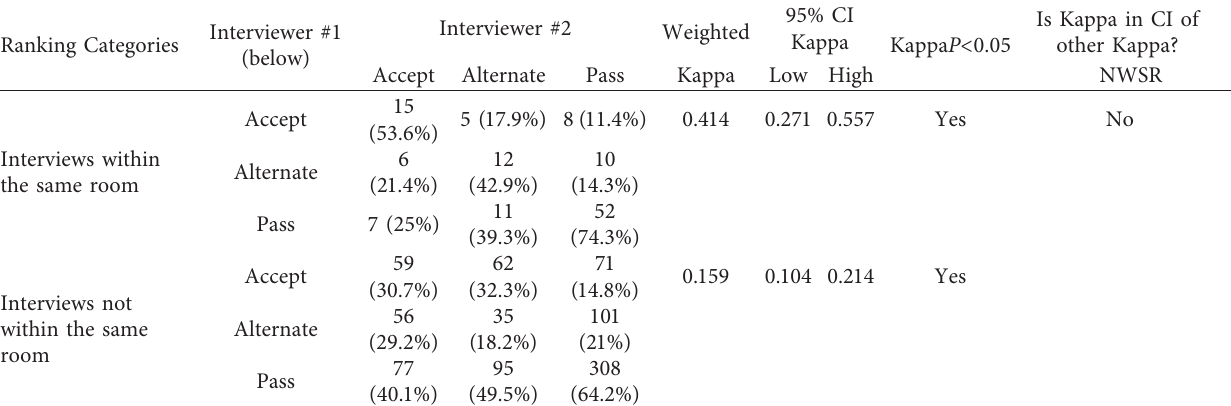
Table 1: Comparison of ranking variabilities of interviewers who shared the virtual interview rooms to those who did not share a virtual interview room. Groups compared Diff. NWSR to WSR 1 NWSR to WSR 2 NWSR to WSR 3 NWSR to WSR 4 NWSR to WSR 6 NWSR to WSR 7 − 1.36 NWSR, not within the same room; WSR, within the same room. ∗ p < 0 . 05, ∗∗ p < 0 . 01, ∗∗∗ p < 0 . 001, † p < 0 . 15 (marginally significant). Mean diff. (beta), mean difference resulted from WSR subtracting NWSR rank range; a negative value denotes greater variability within the NWSR pairs when compared to WSR Table 2: Agreement of candidate categories between pairs of interviewers that are within the same room and not within in the same room Ranking Categories